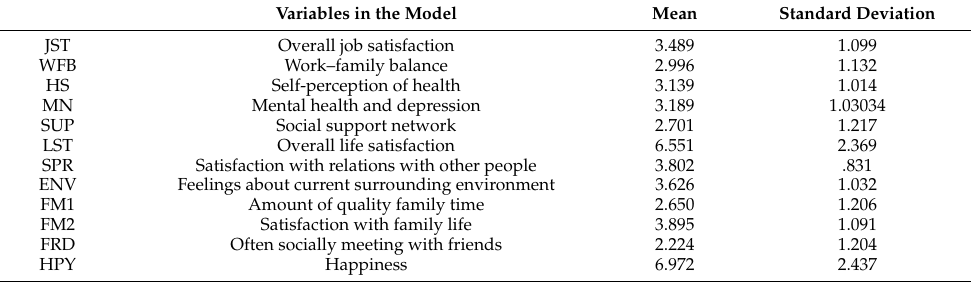
Table 2. Scale types, means, and standard deviations of variables in the